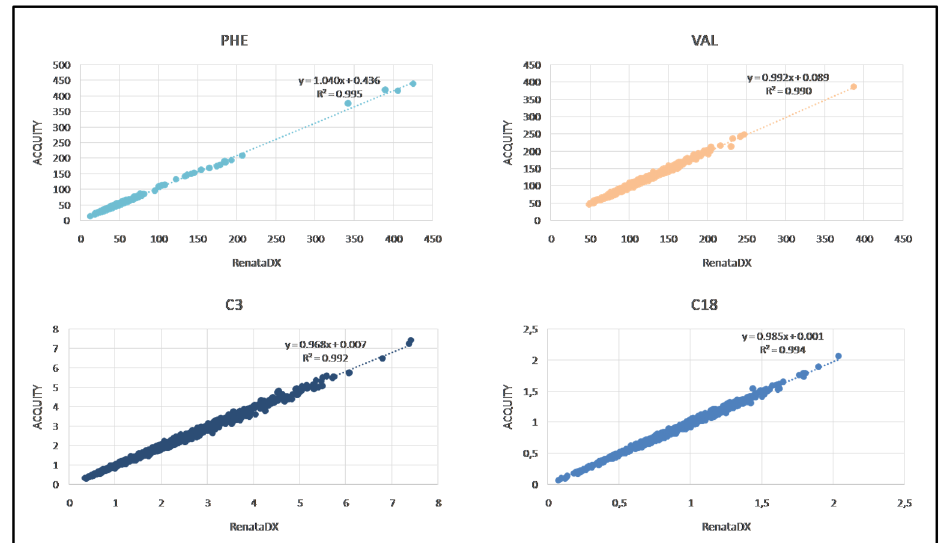
Figure 1. Correlation curves of Phe and Val as aminoacids and C3 and C18 as acylcarnitines, showing the equation of the linear regression analysis and their respective R 2 values.